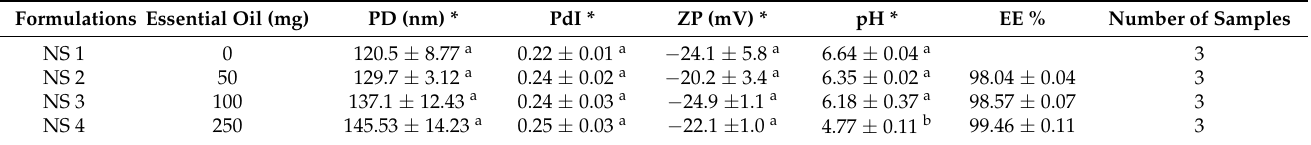
Table 3. Particle diameter (PD) values, polydispersity index (PdI), zeta potential (ZP), pH and percent encapsulation efficiency (EE%) of nanosphere suspensions (NS) containing essential oil of Z. rhoifolium